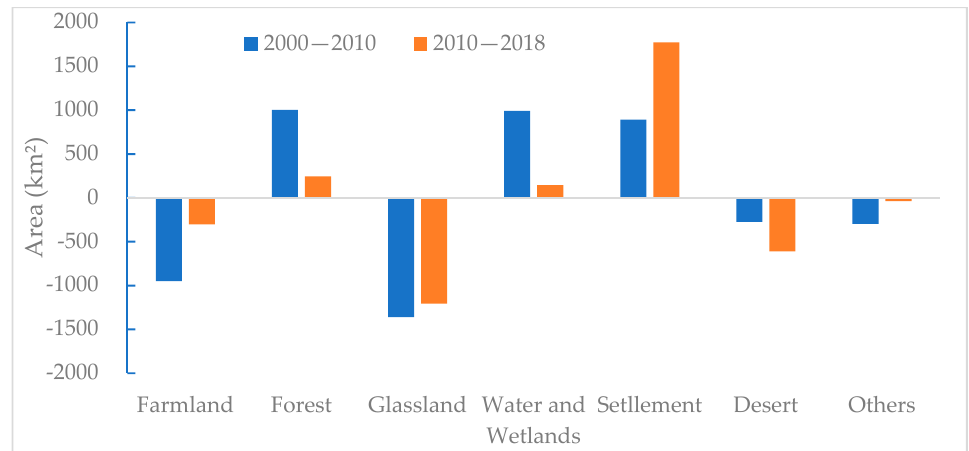
Figure 2. Areal changes of various ecosystem types in the Upper Yellow River region from 2000 to 2010 and from 2010 to 2018.